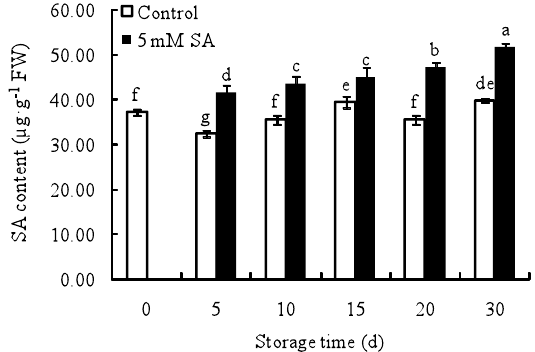
Fig. 2: Changes of SA content of peel in ‘Huangguan’ pear by SA treatment during cold storage. Values are mean ± SE of three replicates. Different letters represent significant differences at P =